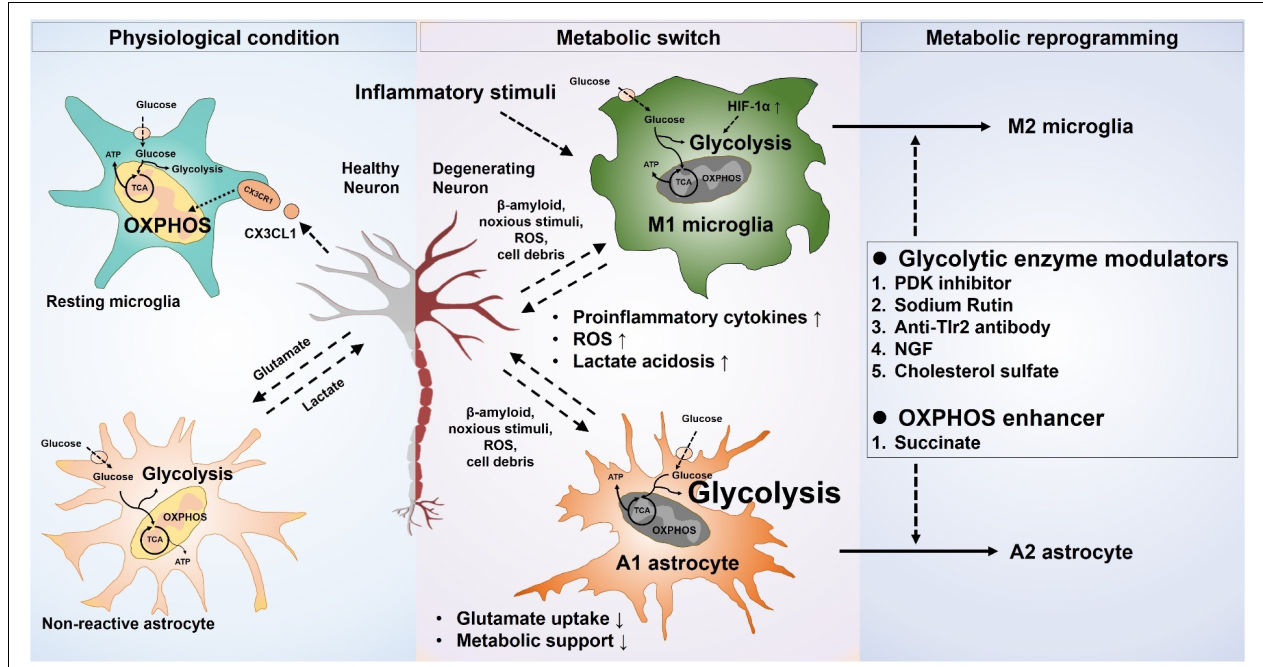
FIGURE 1 | Metabolic modulation of glial phenotypes. Inflammatory stimuli induce neurotoxic glial phenotypes by increasing glycolysis and decreasing mitochondrial oxidative phosphorylation. Increased glycolysis results in an exaggerated release of proinflammatory cytokines, as well as oxidative burden. The proinflammatory cytokines released from the neurotoxic microglia can also propagate the signal to astrocytes, likewise, the neurotoxic astrocytic activation potentiates the neurotoxic microglia. Neuronal survival and integrity are negatively affected by the increased neuroinflammation, leading to a worse outcome in the neurological disorders. Selective targeting of glucose metabolism can modulate the glial phenotype toward a neuroprotective one and can improve the neuronal health in various disease scenarios.